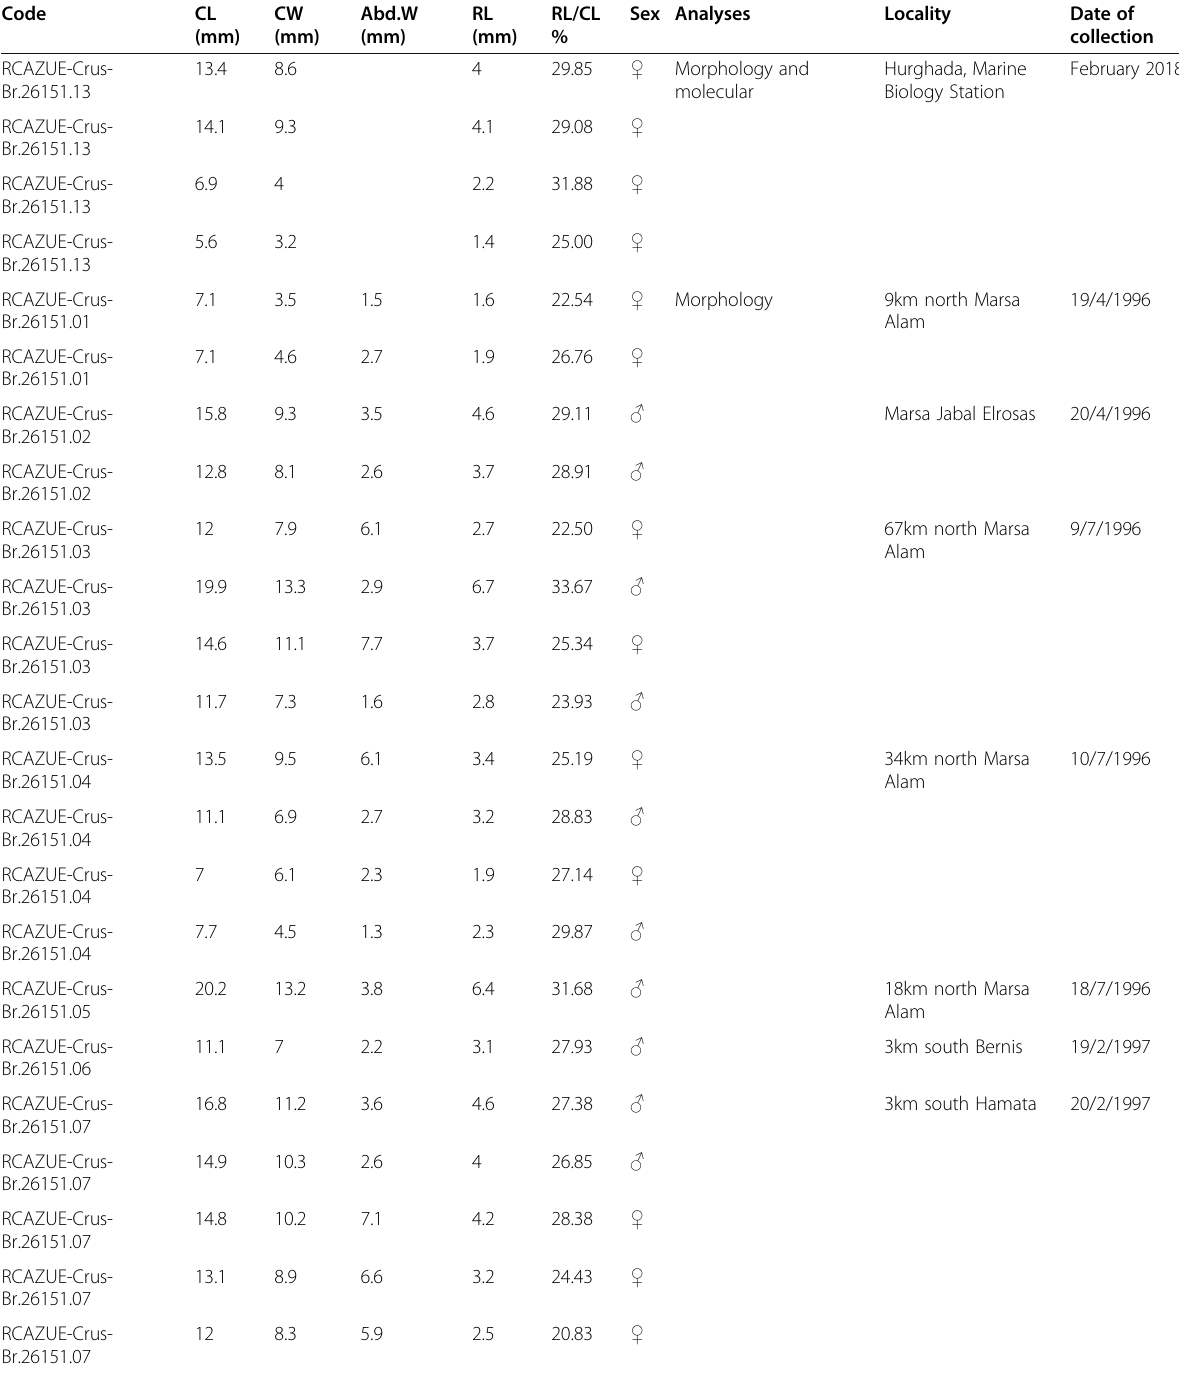
Table 2 Morphometric measurements for the examined materials of M. monoceros , Red Sea, Egypt Code CL